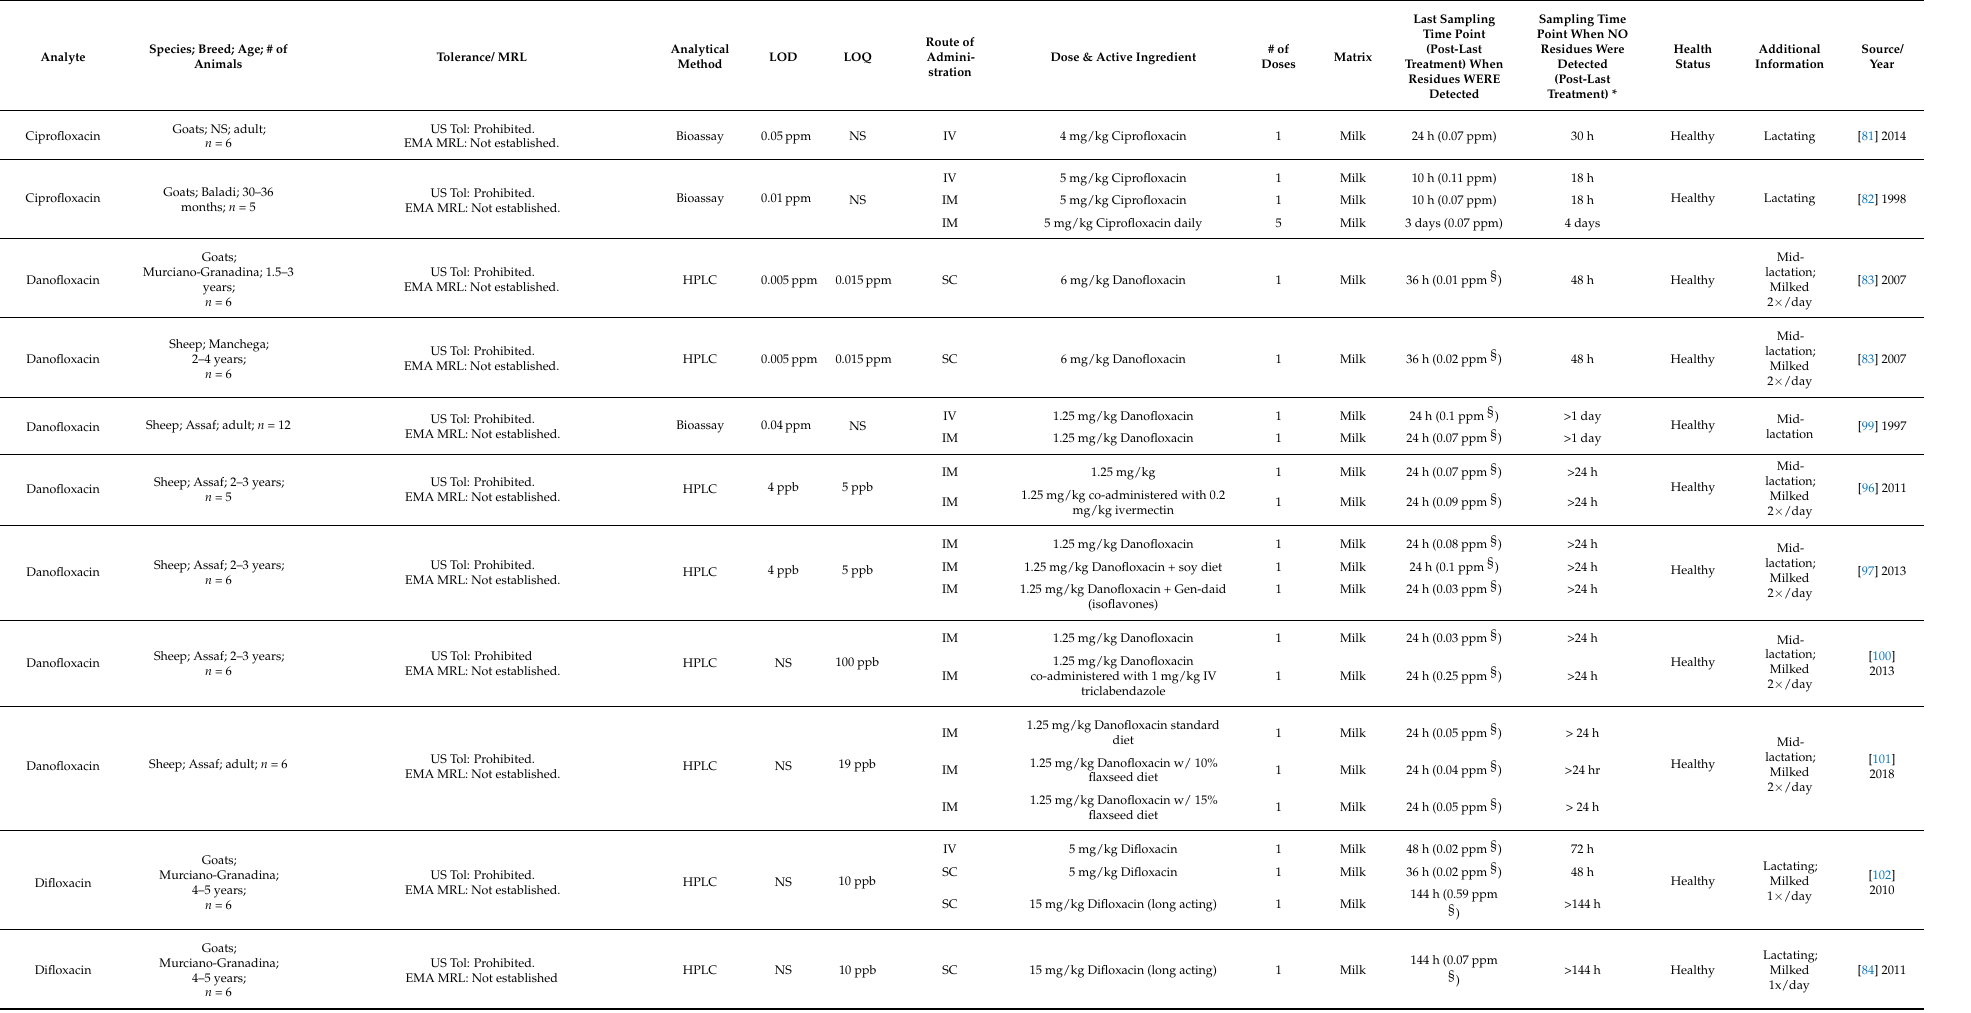
Table 5. Fluoroquinolone residues in milk or edible tissue samples from sheep or goats following treatment.